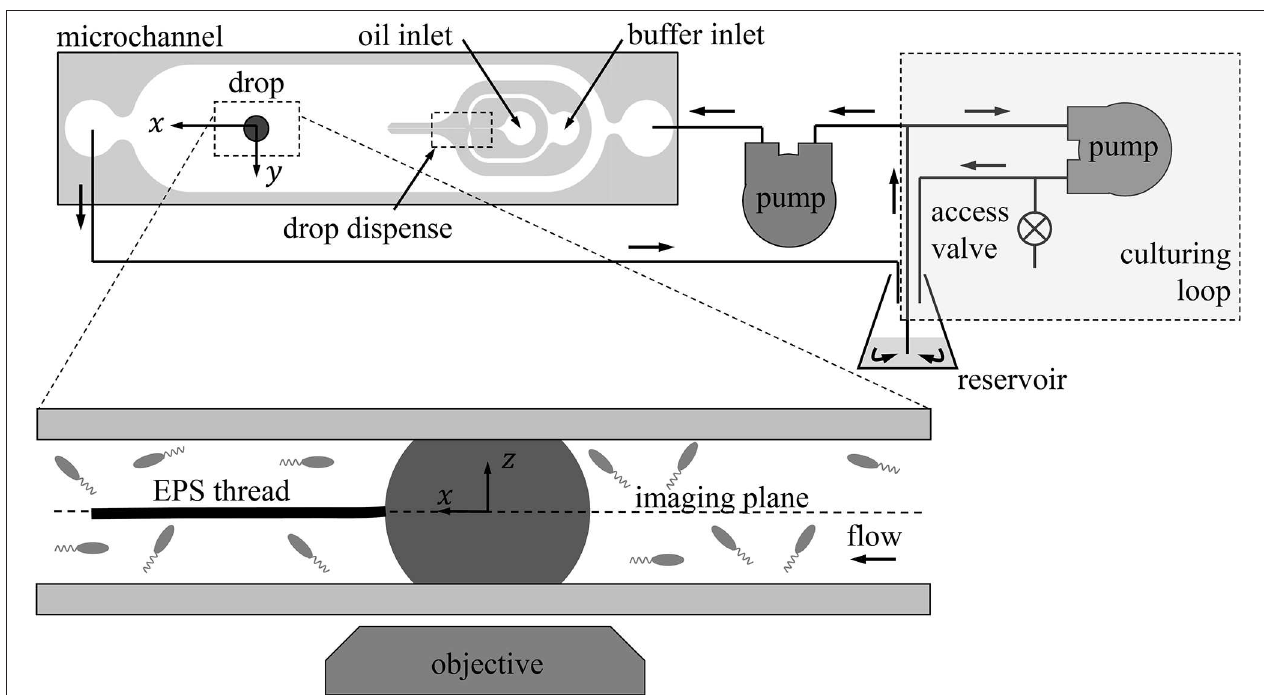
FIGURE 1 | The experimental setup. At the top is the fluidics circuit consisting of the culturing loop (top right) where Pseudomonas sp. are cultured in situ and the observation loop that includes the microchannel (top left). The drop is generated in the flow focusing region indicated by “drop dispense.” The bulk of the bacteria suspension is contained in the reservoir (125ml flask) during the experiment. A vertical cross section of the channel containing the pinned oil droplet is shown in detail at the bottom of the